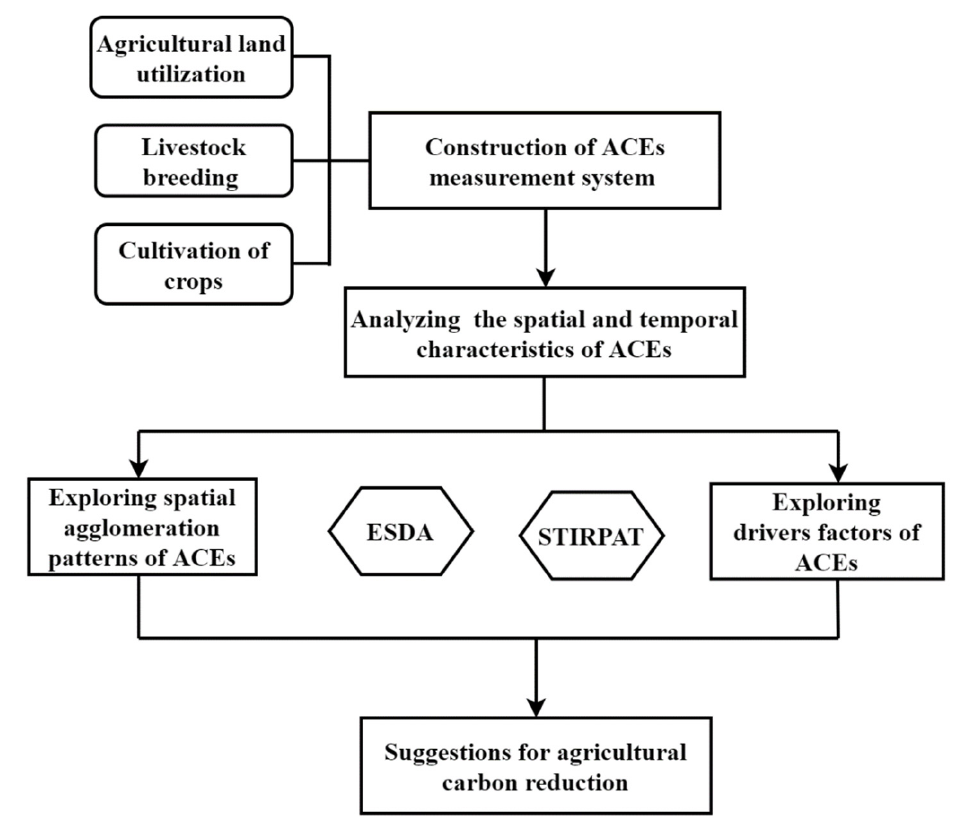
Figure 1. Analysis Framework.